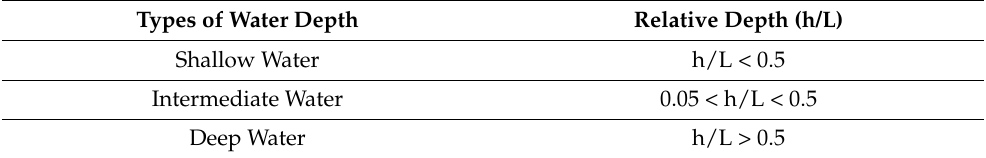
Table 3. Categories of water